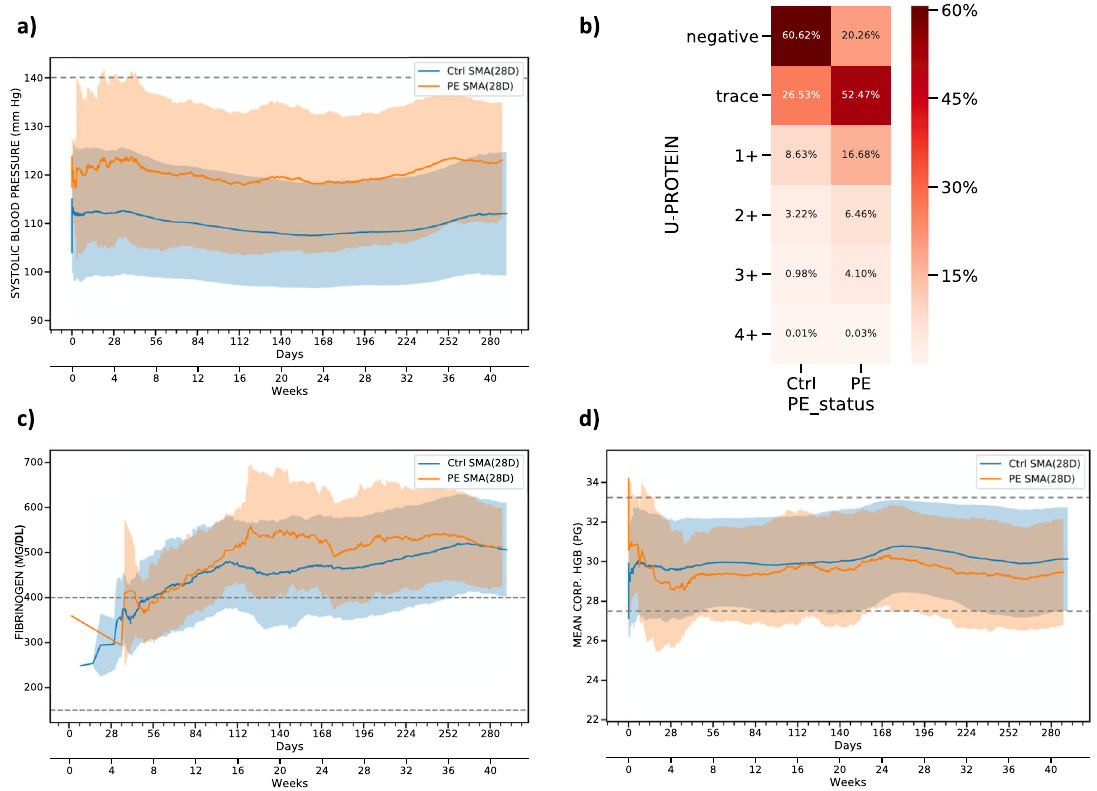
Fig. 4 Feature inspection for antepartum based on moving average. a 28 days moving average of systolic blood pressure for PE and control patients. The dashed line shows the normal range of systolic blood pressure. b Distribution of urine protein for PE and control patients. c 28 days moving average of fi brinogen for PE and control patients. The dashed line represents the reference ranges for fi brinogen. d 28 days moving average of mean corpuscular hemoglobin (HGB) for PE and control patients. The dashed line represents the normal range of mean corpuscular hemoglobin. In the moving average plots, the shaded areas indicate the standard deviation and solid lines represent the average value across the